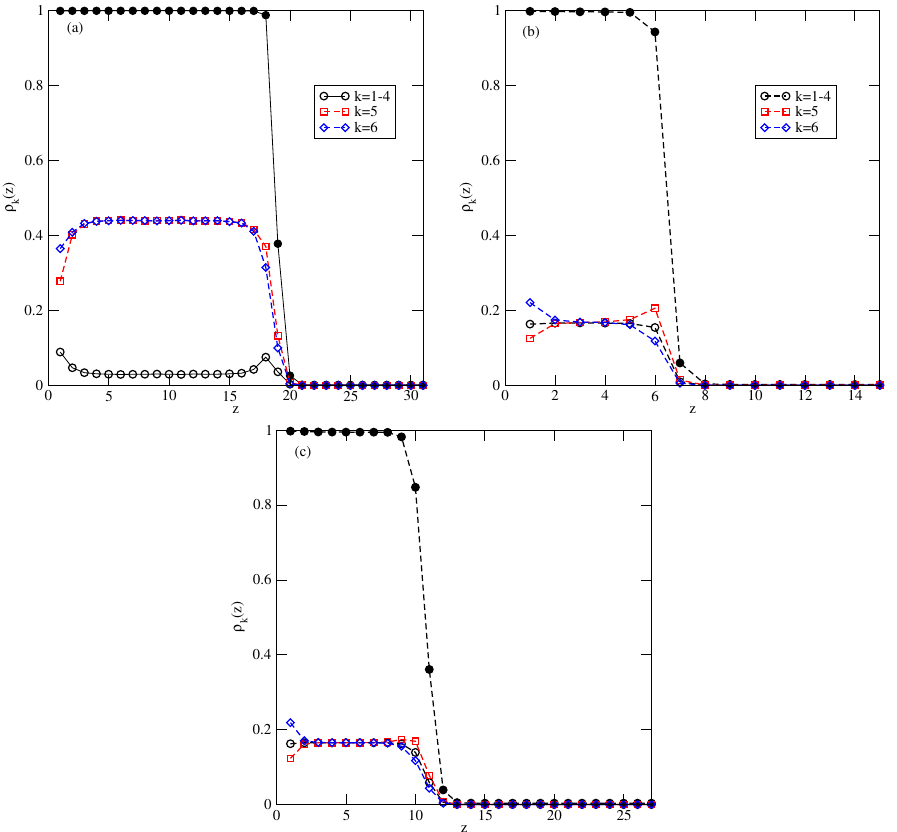
Figure 19. The local density profiles recorded for u AB = − 1.0, u BB = 0 and V o = − 1.0, recorded at T = 0.36 and = − 2.359 ( a ), T = 0.39 and = − 2.341 ( b ) and at T = 0.42 and = − 2.3345 ( c ). The filled circles correspond to the total local density profile, ρ ( z )